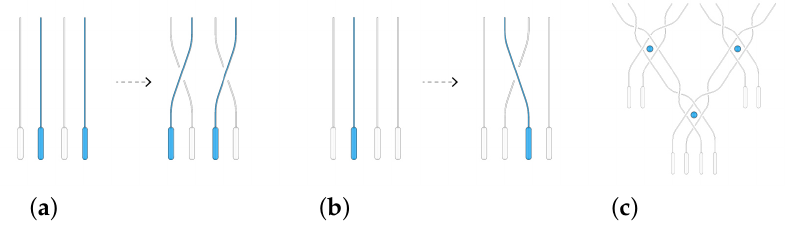
Figure 2. Bobbin lace making technique. Adapted from [13]. ( a ) Twist. ( b ) Cross. ( c ) Pin.